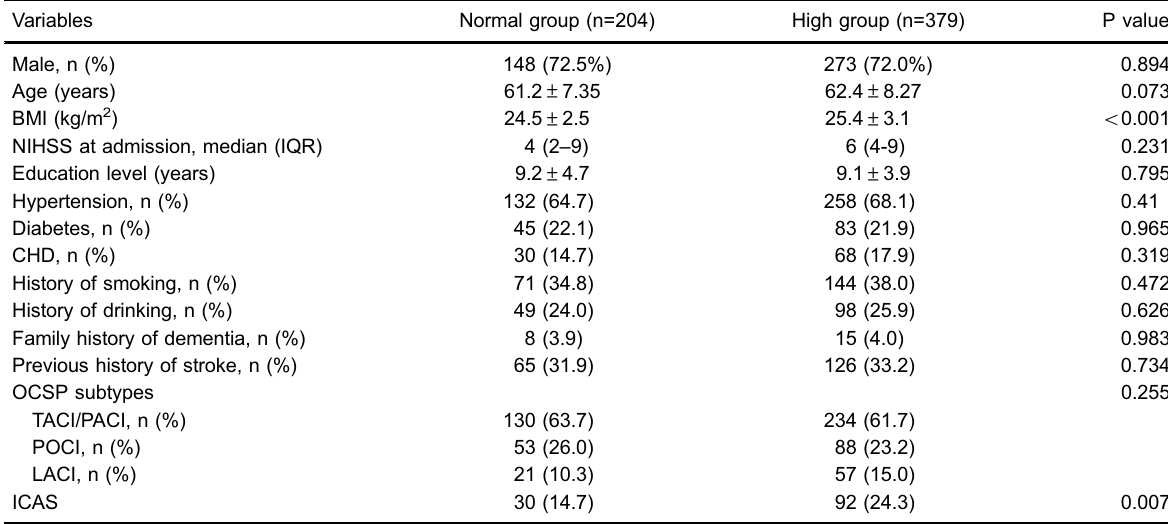
Table 1. Characteristics of the patients of the normal and high non-high-density lipoprotein cholesterol groups.